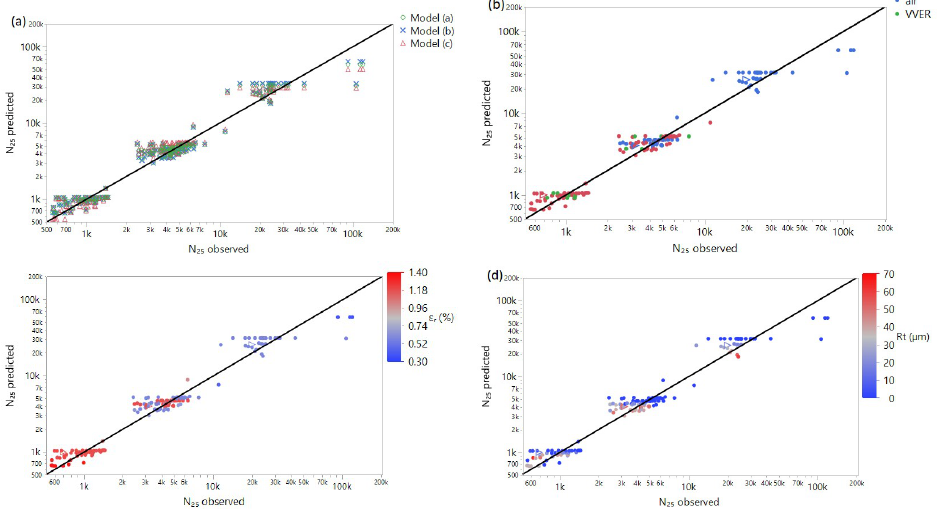
Figure 5. Model predictions for N 25 vs. experimental values: ( a ) comparison between the models ( a – c ). For the predictions with Model ( a ), colour coding highlights the different environments ( b ), strain ranges ( c ) and the surface roughnesses ( d